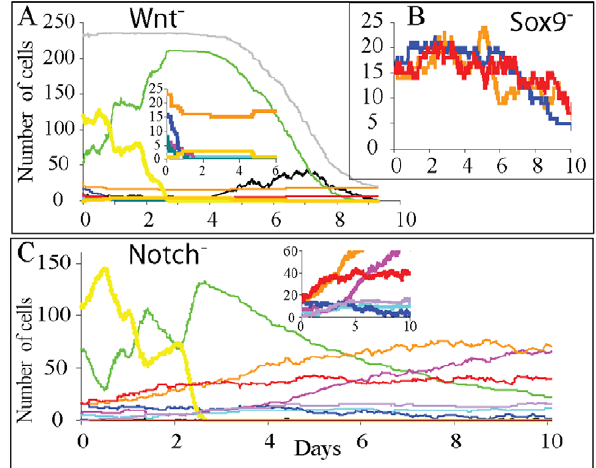
Figure 4. Blocking Wnt and Notch signalling in a steady state crypt. A) Blocking the Wnt signalling pathway halts cell proliferation and differentiation. Between days 2–3 all cells in the crypt differentiate into the enterocyte lineage with some aberrant Paneth cells scattered along the crypt. The colour code is as in Figure 3 with light orange lines representing aberrant mislocated Paneth cells in the crypt. Insert shows secretory and stem cells. B) Deletion of the Sox9 transcriptional factor of the Wnt signalling pathway blocks Paneth cell maturation which is coincident with a decline in the number of stem cells that co-localize with residual Paneth cells; C) Five or six days after blocking the Notch signalling pathway the entire proliferative absorptive progenitors compartment is populated exclusively by secretory cells , and while all secretory cell compartments expand, the number of stem cells decreases. Insert shows secretory and stem